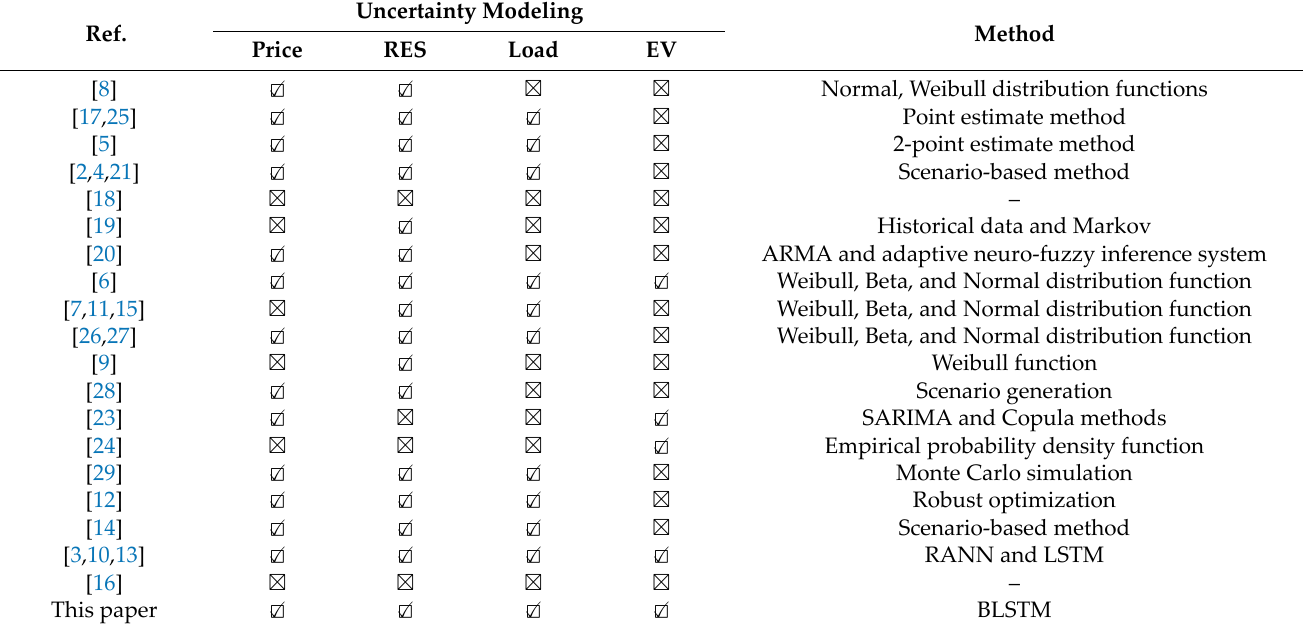
Table 2. A survey of methods for modeling stochastic parameters in VPPs.